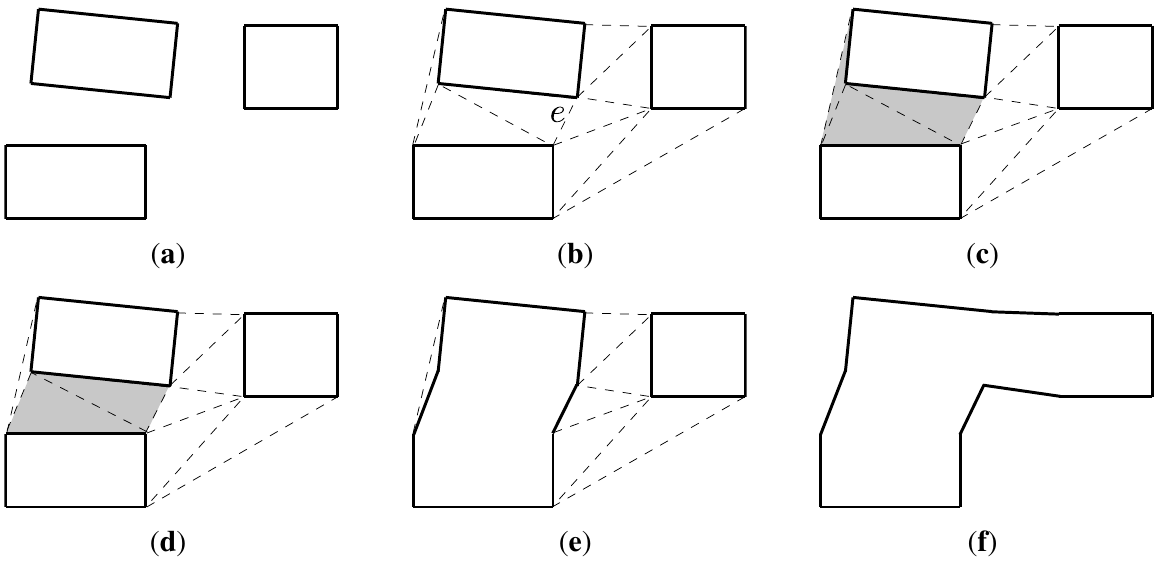
Figure 4. The three polygon in ( a ) are merged, through steps ( b ) to ( e ), to give the result in ( f